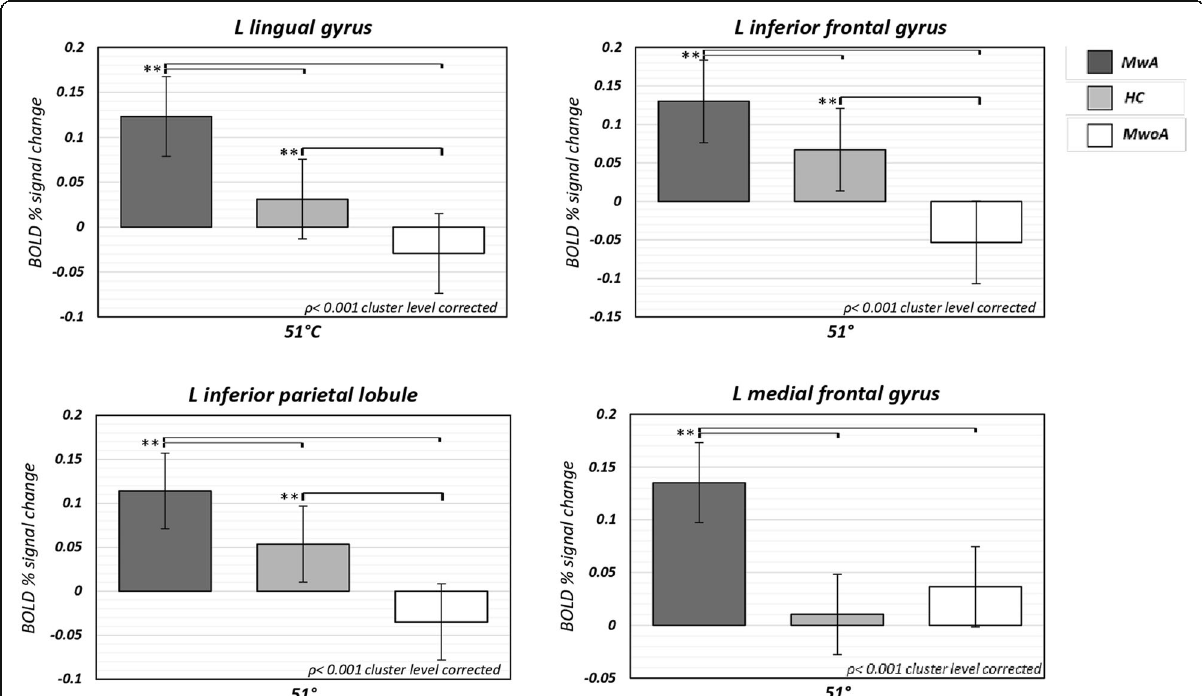
Fig. 2 Percent of BOLD signal change (mean ± SE) at 51 °C from left lingual gyrus, left inferior parietal lobule, left inferior frontal gyrus and left medial frontal gyrus clusters in patients with MwA compared to HC and patients with MwoA. SE = standard error; MwA = migraine with aura; HC = healthy controls; MwoA = migraine without